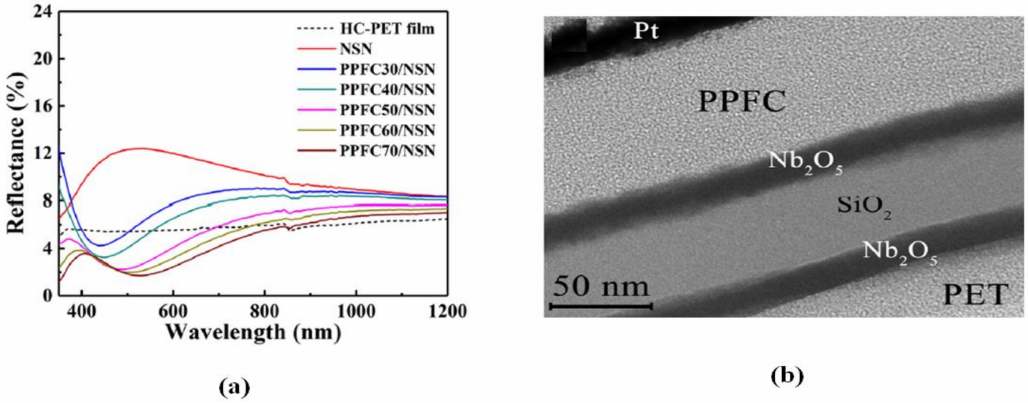
Figure 26. ( a ) Reflection spectra of HC-PET substrate film, trilayered NSN thin film, and quadrilayered PPFC / NSN thin films in 350 to 1200 nm wavelength range. ( b ) Cross-sectional TEM image of quadrilayered PPFC70 / NSN thin film. Reprinted with permission [242]; 2019,